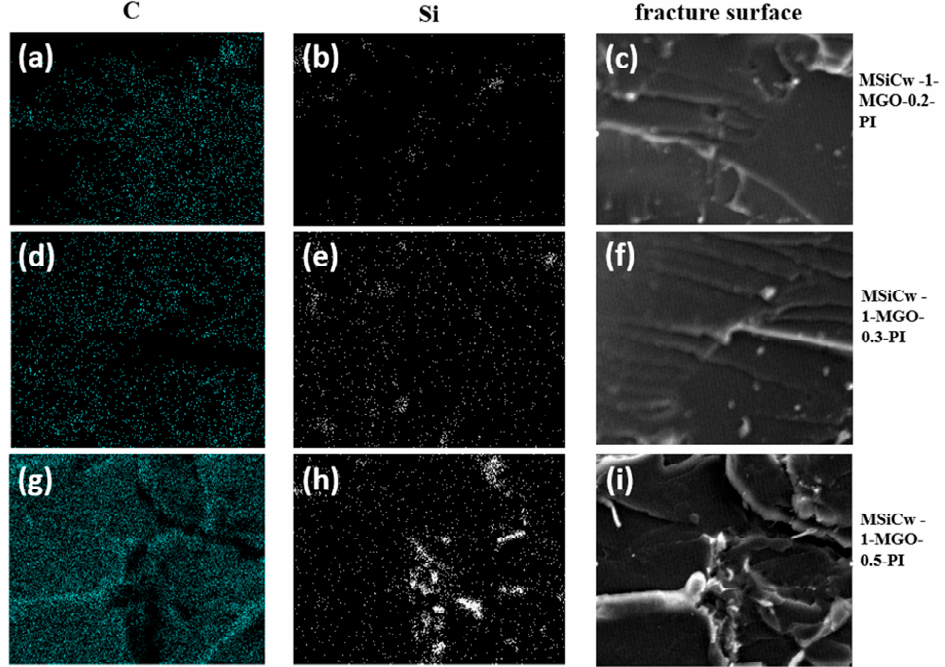
Figure 7. Elemental mappings of C ( a , d , g ) and Si ( b , e , h ) of fracture surface MSiCw-1-MGO-0.2-PI ( c ), MSiCw-1-MGO-0.3-PI ( f ) and MSiCw-1-MGO-0.5-PI ( i ).